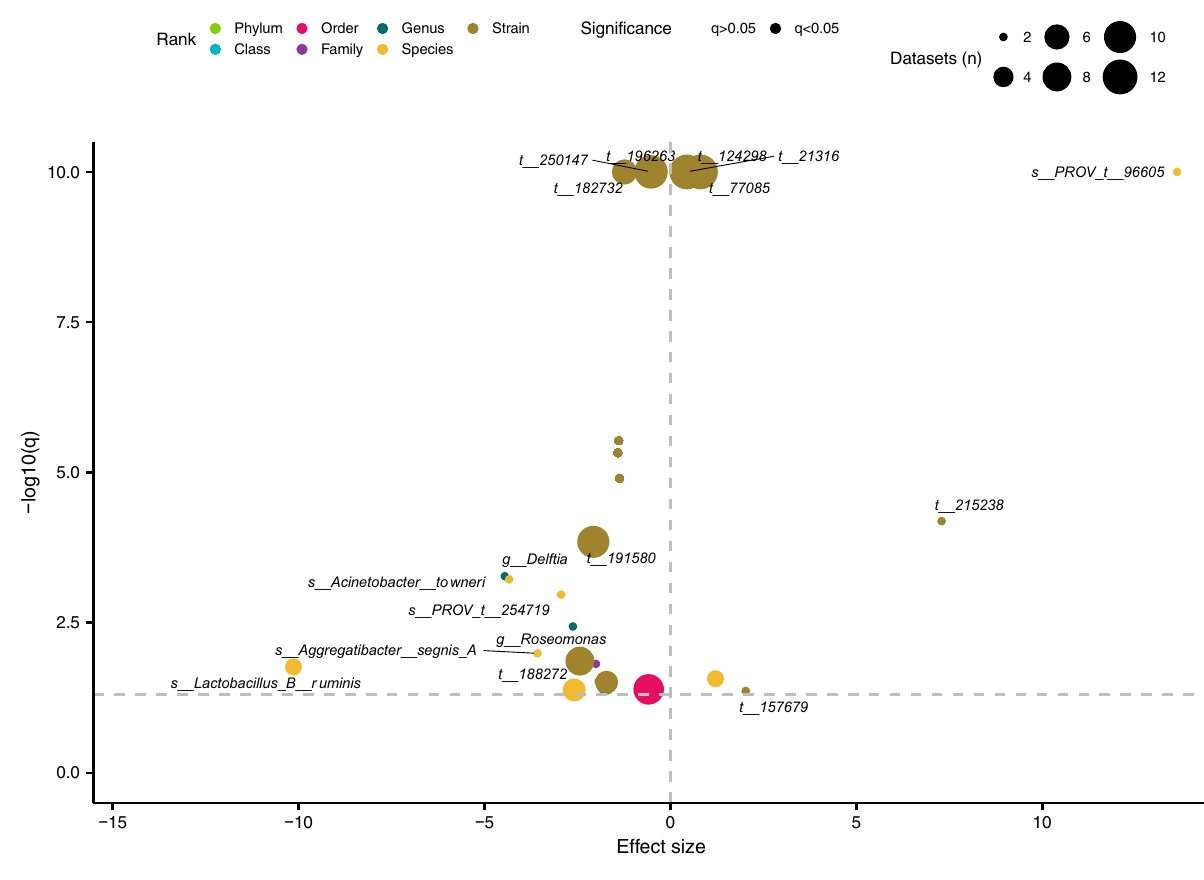
Figure 3. Features associated with ASD at different taxonomic levels. Effect sizes and q -values from random- effects models (meta-analysis) are plotted. Each model represents an association between the abundance of a specific taxon and ASD (negative direction) or NT (positive direction). The color, transparency, and size of each point denotes the taxonomic rank of the taxon, the significance of the model, and the number of datasets included in the model, respectively. Horizontal dotted line indicates significance threshold (q = 0.05). Significant models are labelled by the taxon investigated. Strain-level results are reported in Table